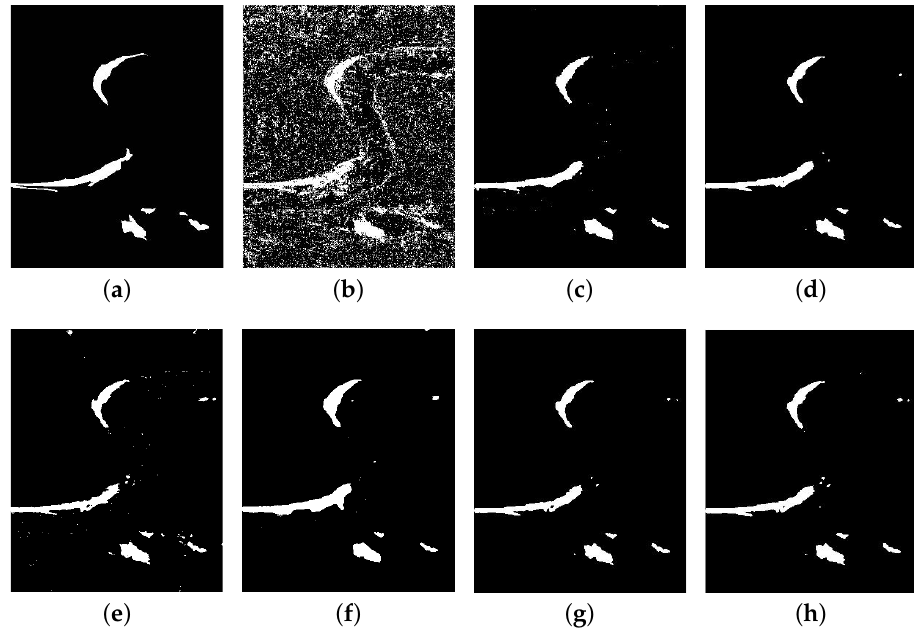
Figure 17. Change detection results of the inland water data set: ( a ) Reference. ( b ) FCM. ( c ) NLMFCM. ( d ) DBN. ( e ) SCCN. ( f ) Wavelet fusion. ( g ) gcForest. ( h ) The proposed method.